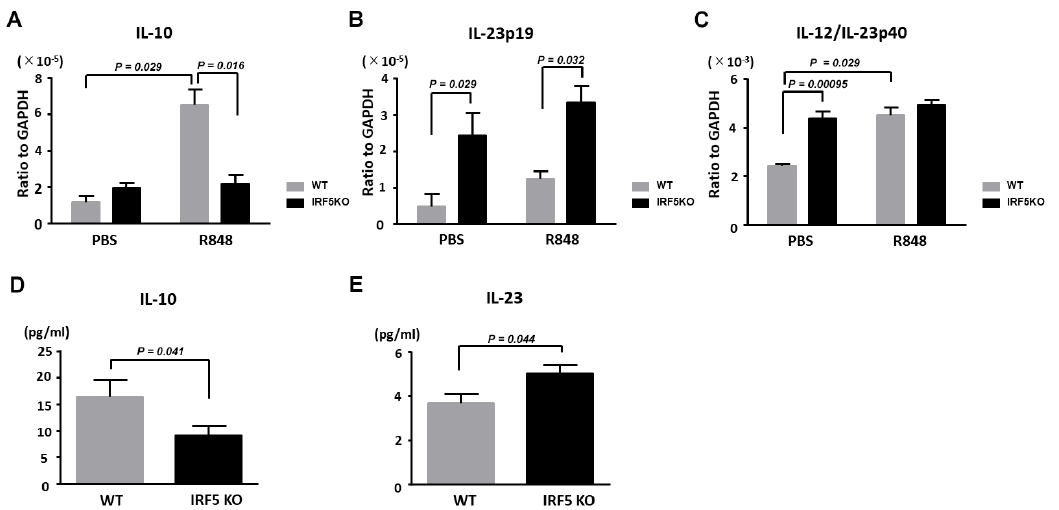
Figure 4. IRF5 deficiency downregulates IL-10 expression and upregulates IL-23 expression by dendritic cells. Dendritic cells (DCs) from the wild-type (WT) or IRF5 knockout (IRF5 KO) mice were stimulated with phosphate-bu ff ered saline (PBS) or 1 µ g / mL R848 for 24 h. Messenger RNA levels of IL-10 ( A ), IL-23p19 ( B ) and IL-12 / 23p40 ( C ) were determined by quantitative RT-PCR. Protein levels of IL-10 in the supernatants after R848 stimulation ( D ) IL-23 in the supernatants without R848 stimulation ( E ) were determined by enzyme-linked immunosorbent assay (ELISA). Data are obtained from duplicate samples from 12 mice in each group. Values are presented as mean the ± SEM of three independent